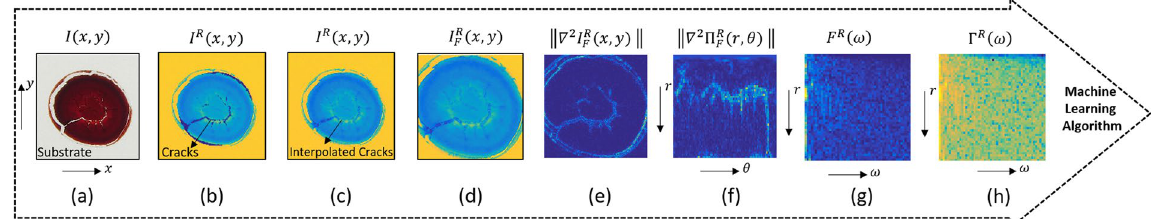
Figure 6. Image pre-processing methods where ( a ) shows the raw blood image, ( b ) represents the red channel of the image, ( c ) illustrates the 2D interpolated cracks, ( d ) shows a 2D Gaussian filtered image, ( e ) shows the Laplacian of the image function, ( f ) is the polar coordinate version of the image, ( g ) is the 1D power spectrum of the image previously shown and ( h ) is the logarithmic power